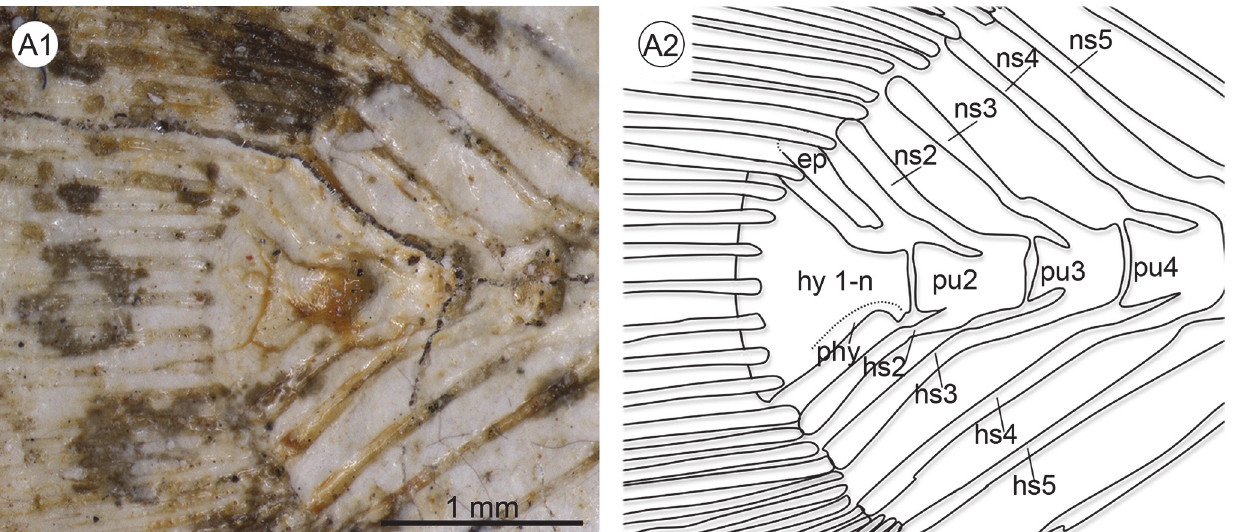
Fig 11. Details of the caudal skeleton of † K . kipkechi sp. nov. (paratype 1220´04). A1 – 2 Caudal fin with overlap between the proximal part of the parhypural, the terminal centrum and the hypural plate, right lateral view. Abbreviations: ep, epural; hs2 – 5, haemal spine of preural vertebrae 2 – 5; hy 1 – n, hypural plates 1 – n; ns2 – 5, neural spine of preural vertebrae 2 – 5; phy, parhypural; pu2 – 4, preural vertebrae 2 –